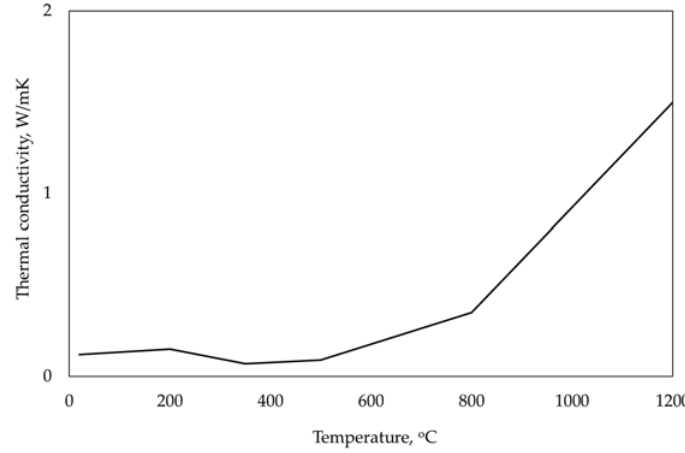
Figure 8. Thermal conductivity of wood.